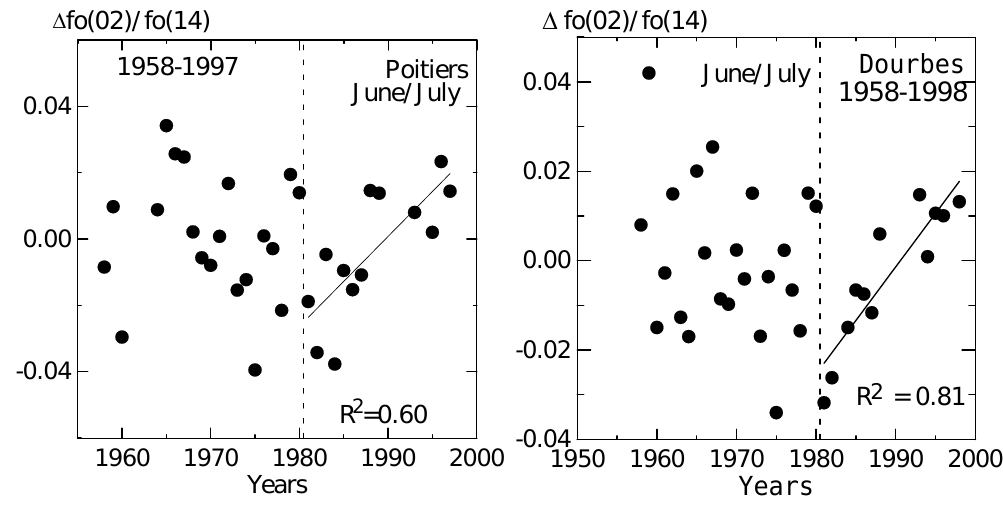
Fig. 12. Time behavior of 1 fo F2(02)/ fo F2(14) for Poitiers and Dourbes. of R ( fo F2) demonstrates the same feature: after about 1980 the magnitude of negative R ( fo F2)